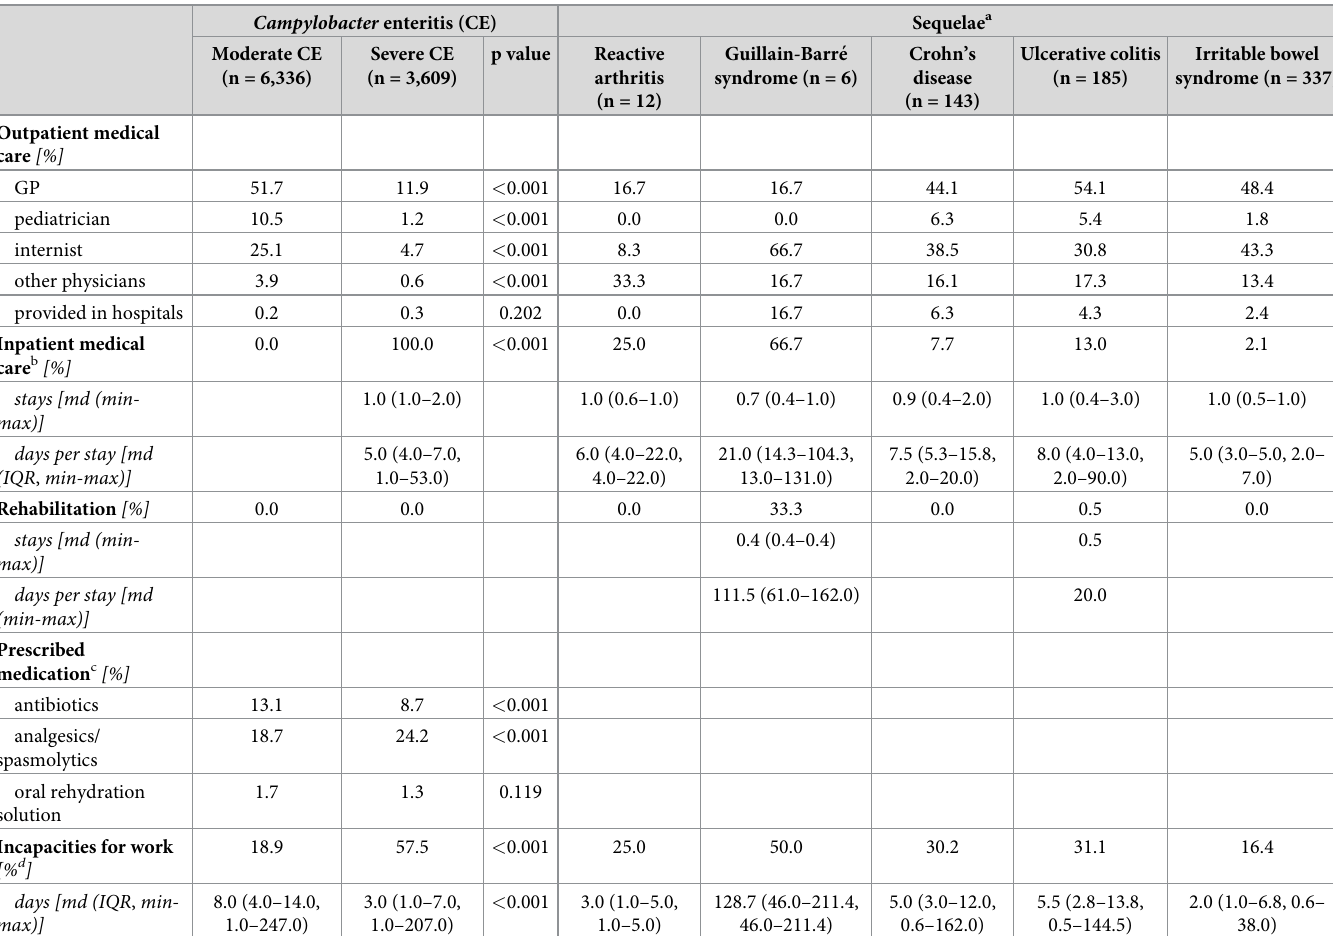
Table 2. Health care utilizations and work incapacities associated with diagnoses of Campylobacter enteritis or sequelae over a 12-month